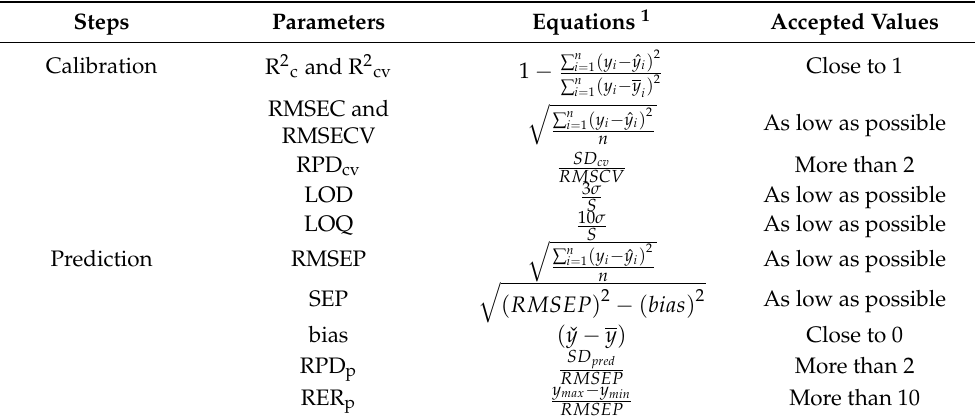
Table 2. Statistical parameters and their equations were used to assess the calibration model and its prediction